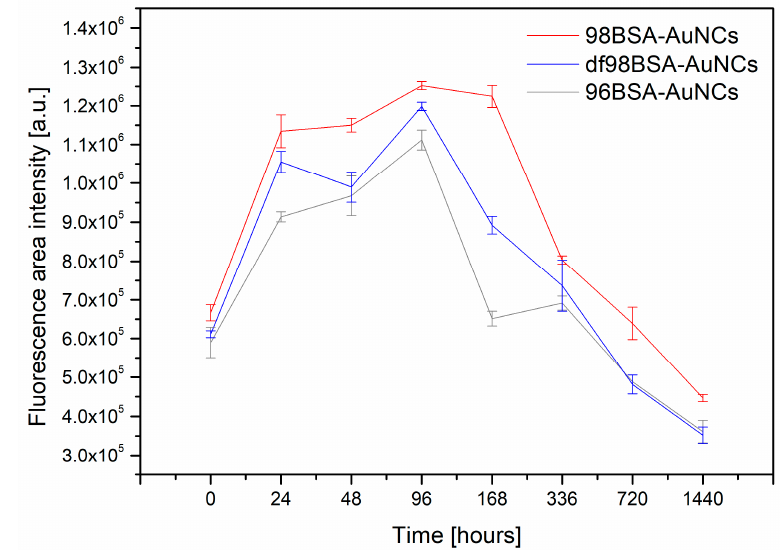
Figure 5. Plot of integral fluorescence intensity of 96BSA-AuNCs (grey), 98BSA-AuNCs (red), and df98BSA-AuNCs (blue) as a function of time elapsed from AuNCs synthesis.